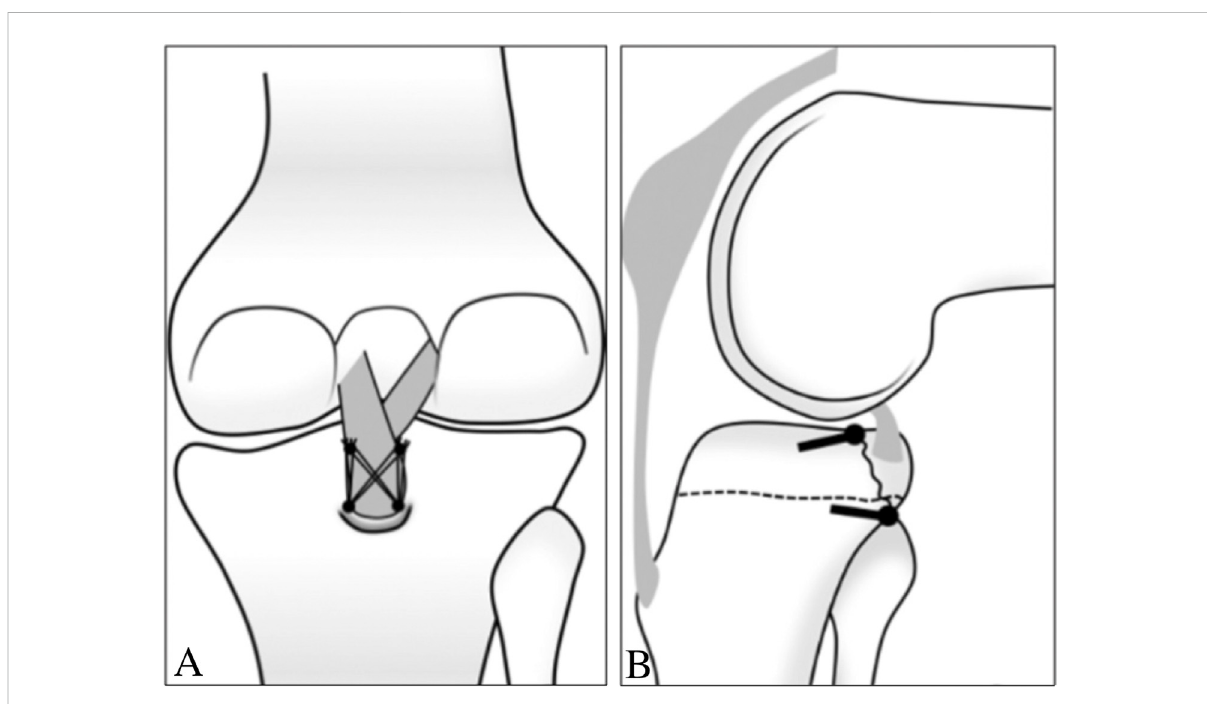
FIGURE 1 Schematic draw of the suture bridge fi xation of PCLAF (Lee et al., 2015) (Copyright 2015; The Korean Orthopaedic Association). (A) 2 bio- absorbable anchors were implanted into the proximal-medical side and proximal-lateral side of the fracture bed, and the fragment of PCLAF was fi xed by threading the 4 strands of the suture through the bone-tendon junction from anterior to posterior, and the 4 strands (2 strands of each anchor) were retrieved and located by external anchors; (B) lateral view, the internal anchors were located proximally, and the external row anchors were located distally of the fracture